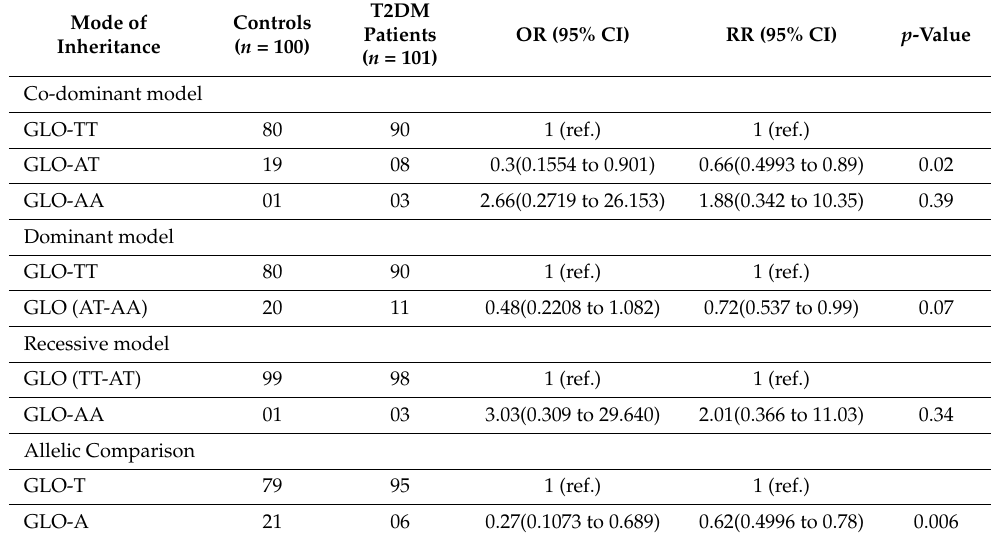
Table 8. Association between GLO-rs1130534 T>A gene variations with T2DM.